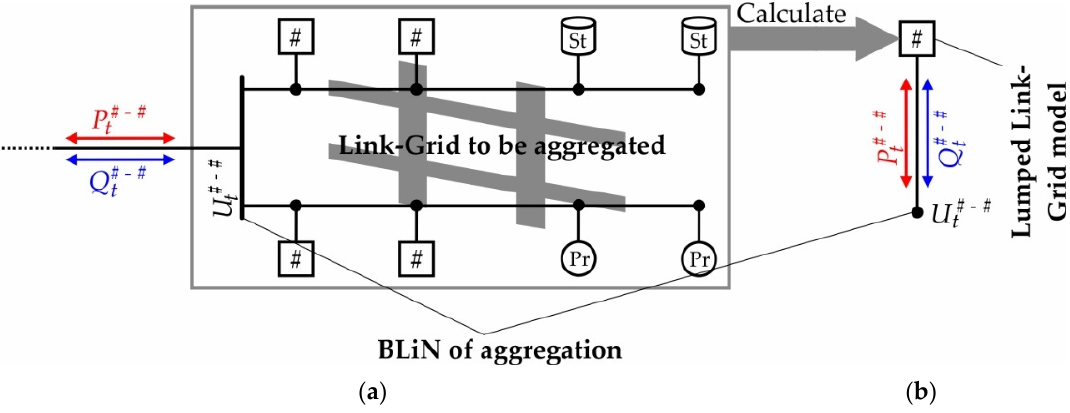
Figure 16. Aggregation of a Link-Grid: ( a ) Link-Grid to be aggregated; ( b ) overall lumped Link-Grid model.